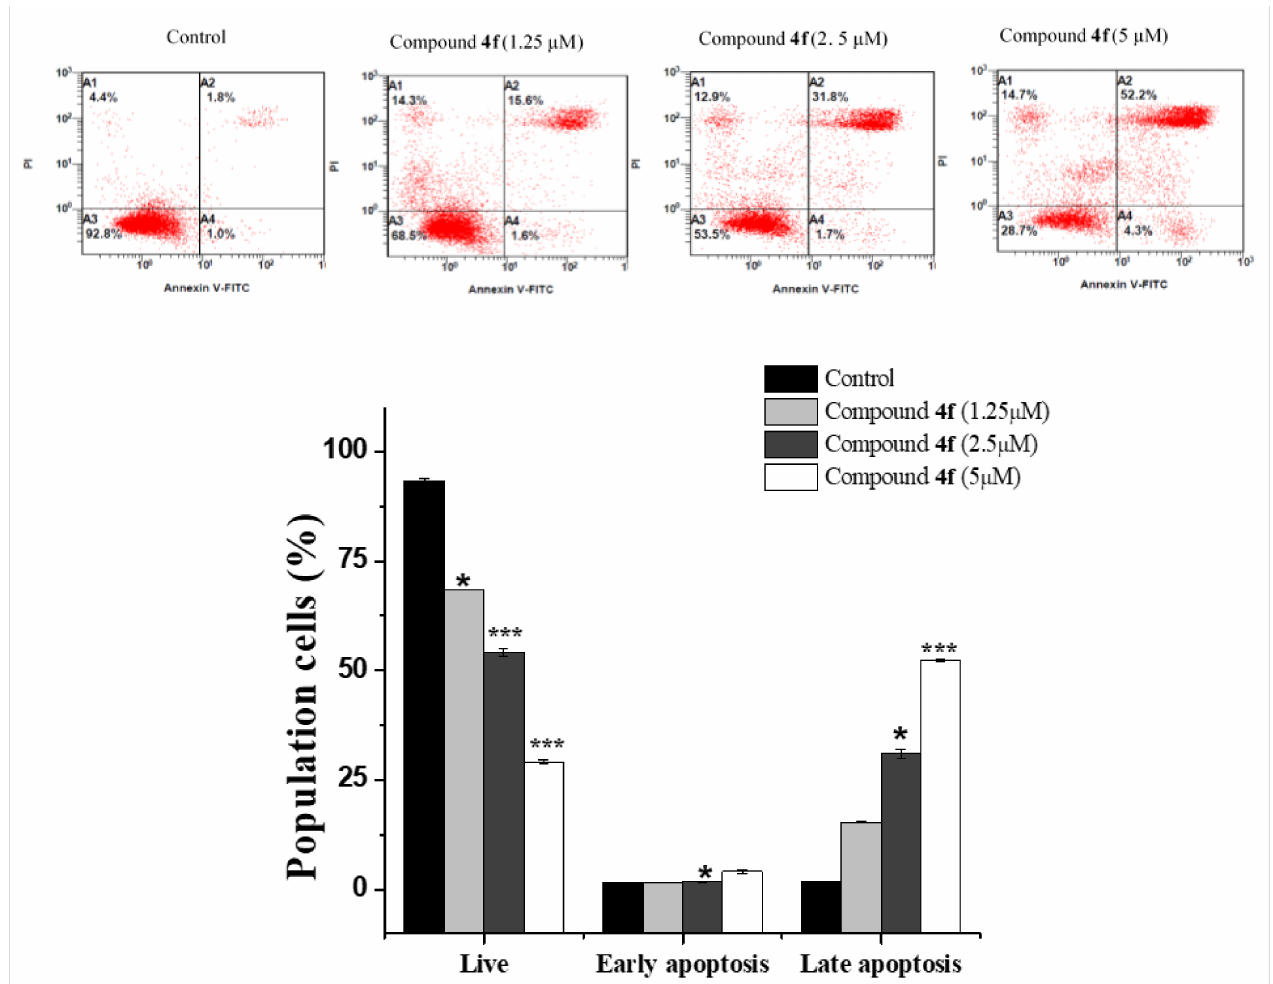
Figure 5. Flow cytometry analysis of compound 4f for MCF-7 cells following 24 h incubation period at indicated concentrations. Dot plot of Annexin V-FITC/PI and bar quantification for evaluation of apoptosis. Values are presented as means ± SD. Significant differences from control group: * p < 0.05, and *** p <